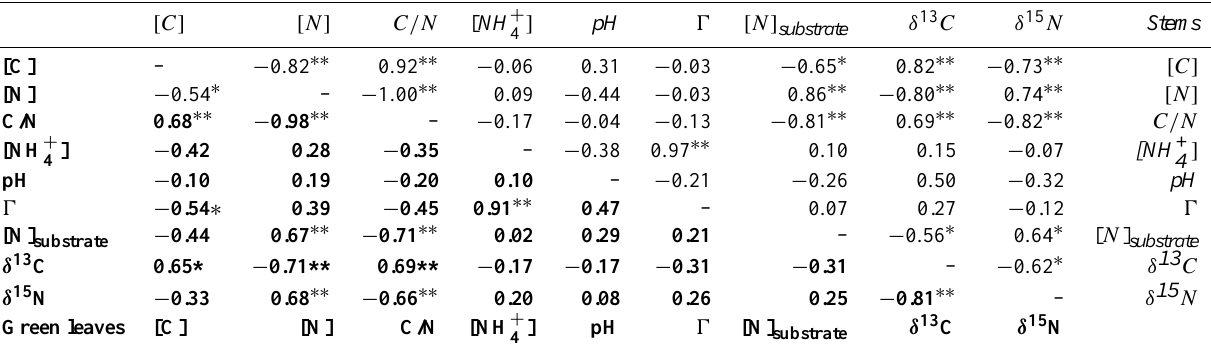
Table 2. Correlation coefficients ( r ) for key parameters in different ryegrass tissues. Numbers in bold in the lower left part of the table are r values for green leaves, while numbers in the upper right part are r values for stems. Correlation analyses were based on Pearson’s product moment if the data met the normality requirements in the Shapiro-Wilk test; otherwise Spearman’s rank order was used. ∗ and ∗∗ denote that r values are significantly different from 0 at the 95% and 99% confidence levels,